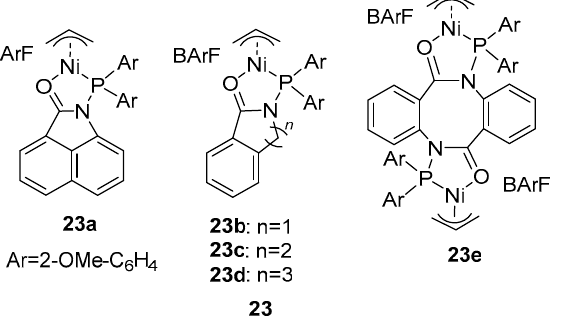
Figure 20. The N -bridged phosphine carbonyl Ni catalysts 23a – e bearing five- to eight-membered- ring.